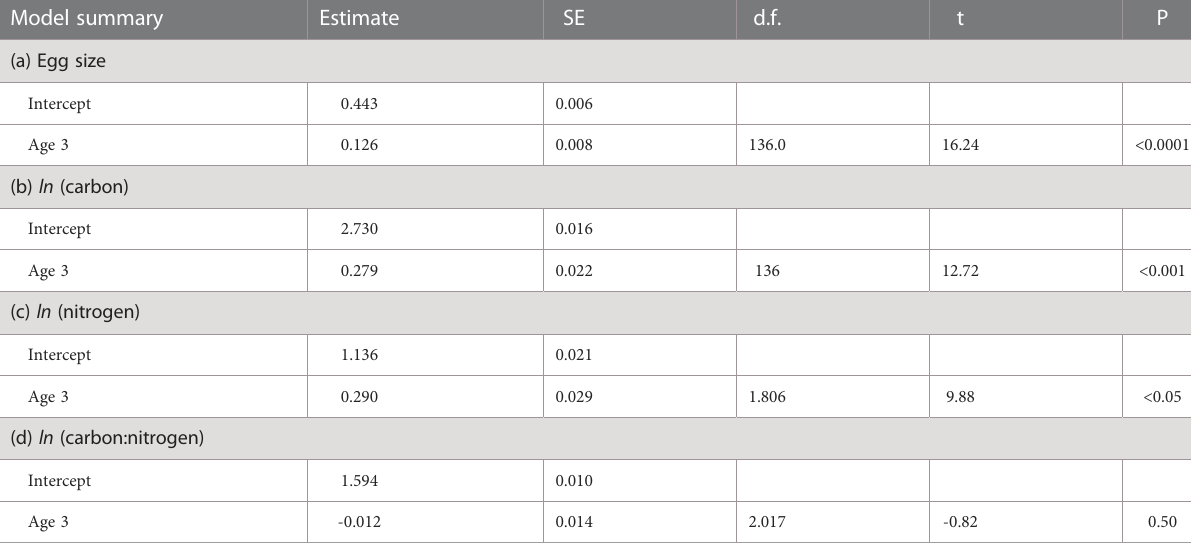
TABLE 2 Summary table for linear mixed effects model estimates fi tted using restricted maximum likelihood for the size (mm 3 ), amounts of carbon and nitrogen, and carbon/nitrogen ratio of eggs of 1-year-old and 3-year-old females. Model